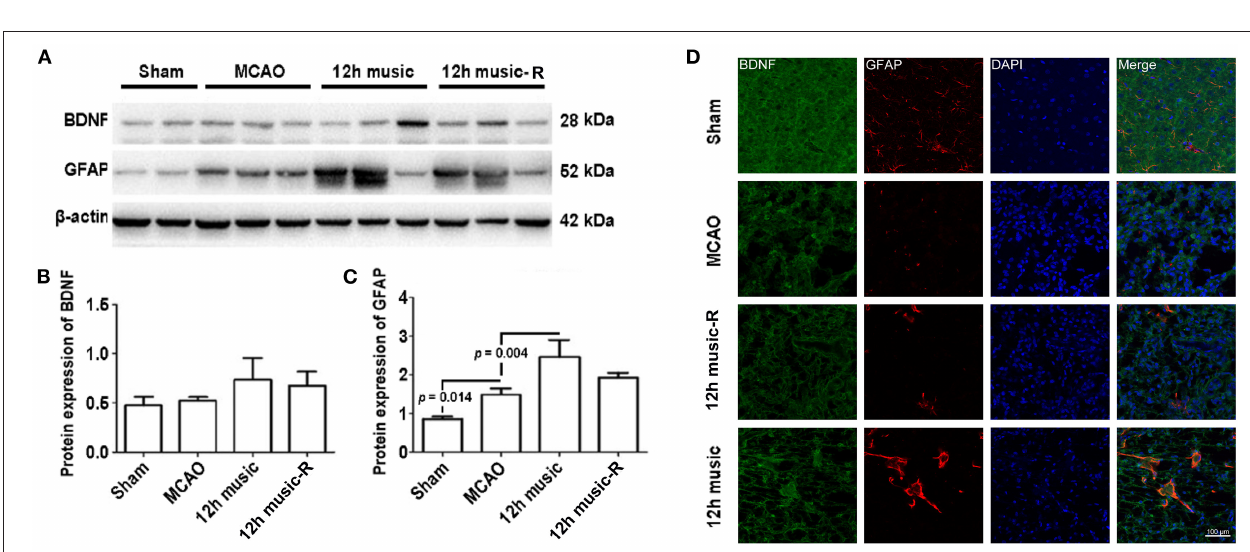
connections, which form an astrocyte morphology. In the 12- h music group, the continuous intervention resulted in longer synapses and clearer cell-to-cell connections, and the GFAP morphology was closer to that of mature activated astrocytes, and the cells differentiated